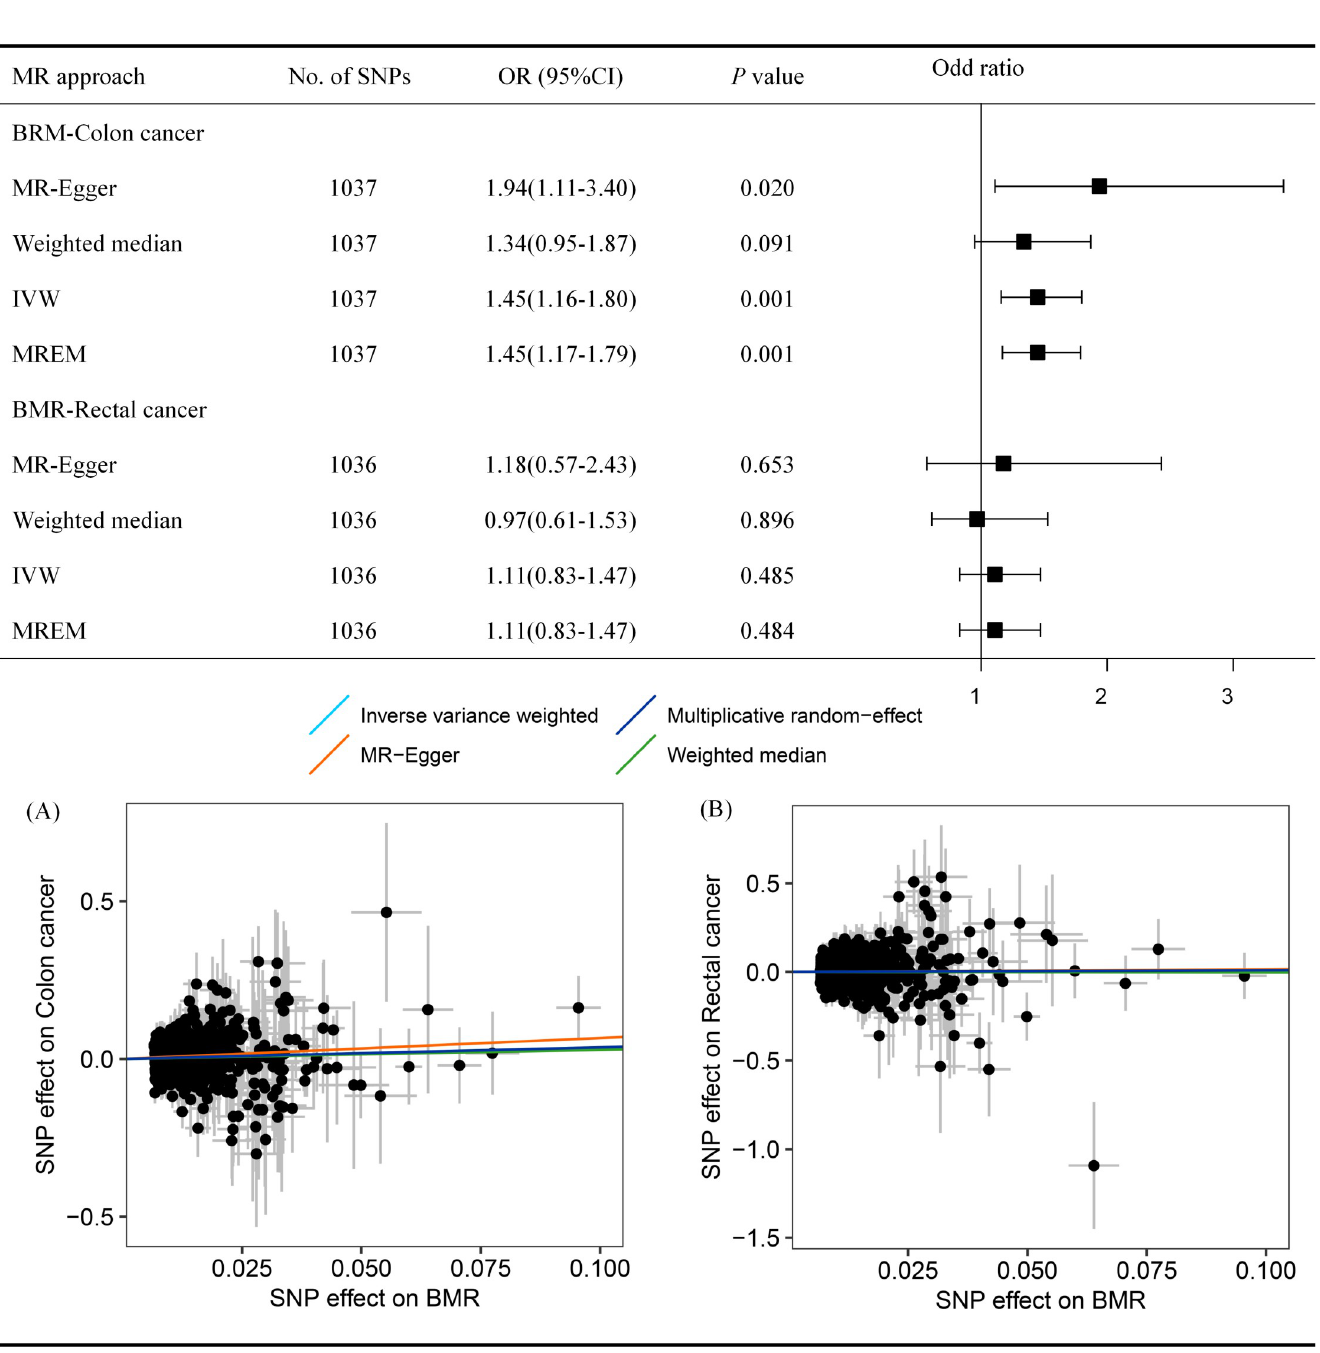
Fig 4. Mendelian randomization estimates the associations between BMR and colon or rectal cancer risk. (A) Scatter plot of BMR-Colon cancer risk MR; p - heterogeneity = 0.824; p -pleiotropy = 0.261 (B) Scatter plot of BMR-Rectal cancer risk MR; p -heterogeneity = 0.541; p -pleiotropy = 0.848. Abbreviation: MR, Mendelian randomization; BRM, Basal metabolic rate; IVW, Inverse-variance weighted. MREM, Multiplicative random-effect model. The p -value remained significant after Bonferroni adjustment for multiple comparisons, namely p -value < 0.025. https://doi.org/10.1371/journal.pone.0273452.g004 cancer and rectal cancer may overestimate or underestimate the relationship between BMR level and specific cancer sites [28], we performed a stratified analysis using summary data of colon cancer and rectal cancer separately and reran the two-sample MR analysis. The findings